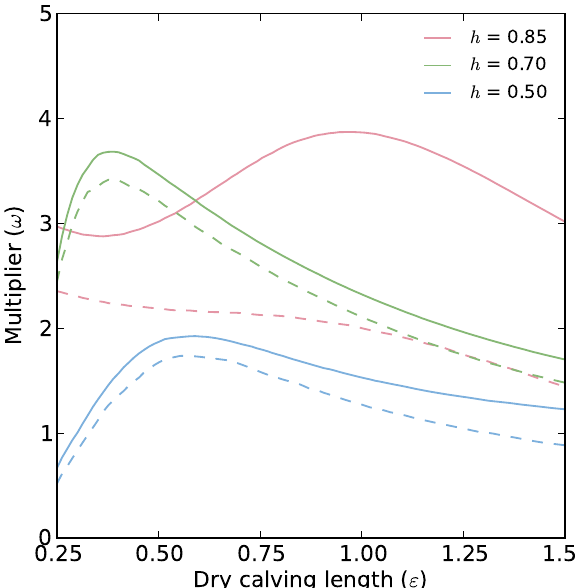
Fig. 7. The effect of a change in basal boundary condition on the ω − ε relationship. Dashed lines show the relationship with an ex- tremely simple linear basal boundary condition. The most signifi- cant change is the reduction in ω for the h = 0 . 85